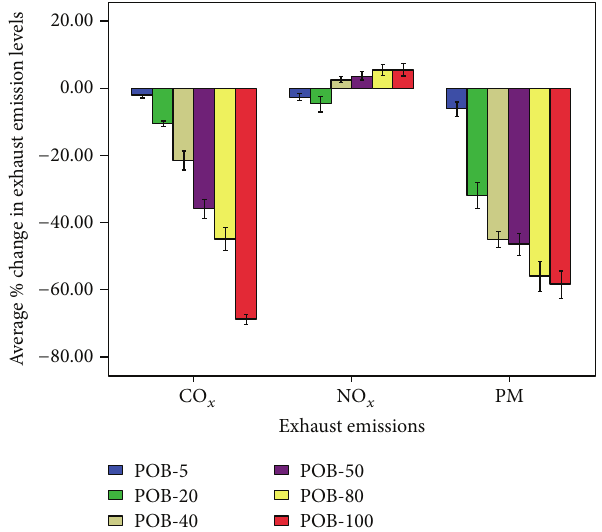
Figure 5: % change in exhaust emissions (CO, NOx, and PM) from engine exhaust operated on different palm oil biodiesel blends comparative to engine exhaust operated on conventional petrodiesel.